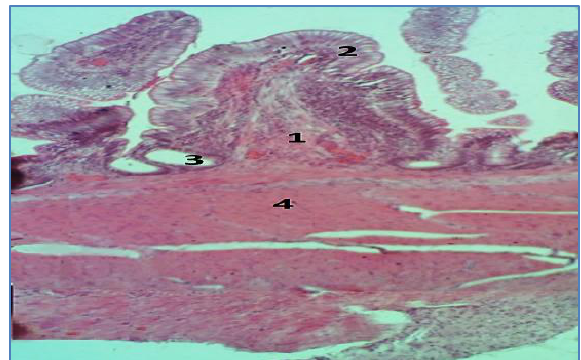
Figure, 2: Coprodeum wall (hen turkey) shows: lamina propria (1), epithelium (2), epithelial tubular gland (3) and tunica muscularis (4), (H and E) satin. 100x.